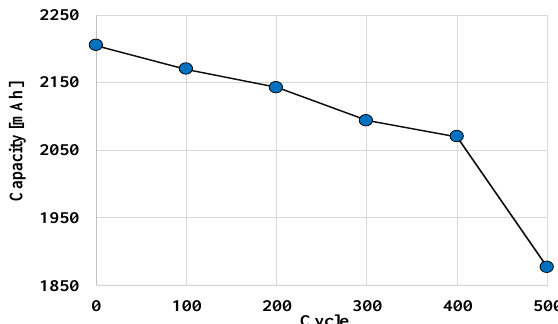
Figure 4. Capacity fade vs. number of charging/discharging cycles.